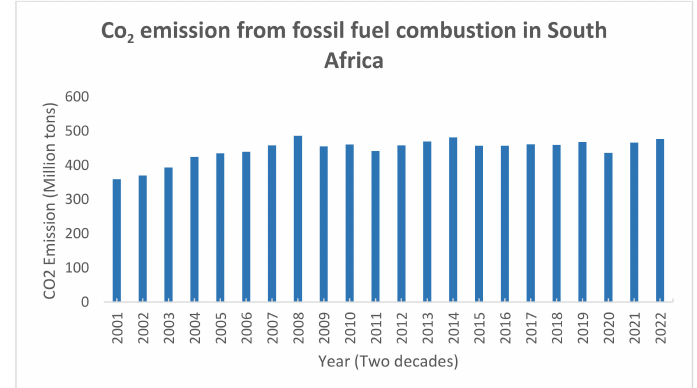
Figure 2. Fossil fuel consumption CO 2 emission in South Africa.